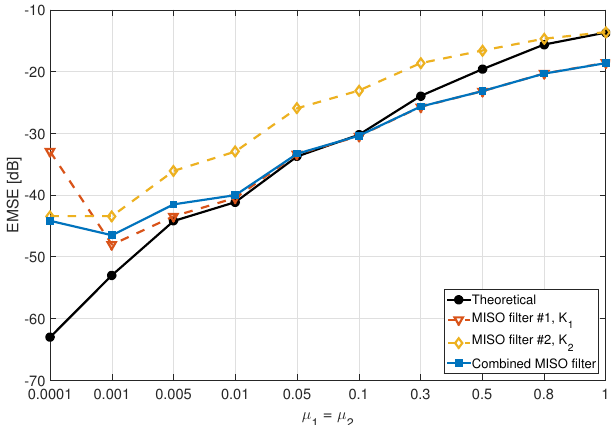
Figure 4. Steady-state theoretical and measured EMSE for a combined MISO filter using different projection